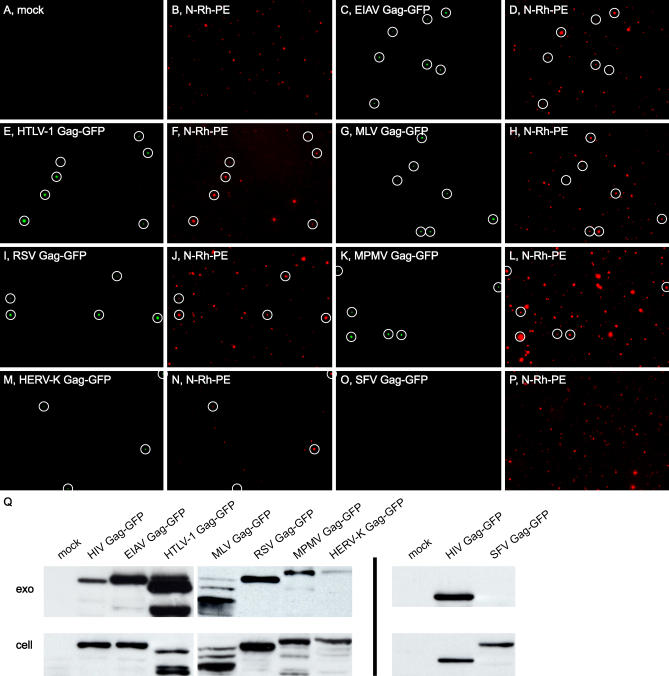
Jurkat T Cells Selectively Sort Orthoretroviral Gag Proteins to Exosomes(A–P) Fluorescence microscopy of exosomes secreted by N-Rh-PE–labeled Jurkat T cells (A and B) untransfected (mock) or transfected with plasmids that express GFP-tagged Gag proteins from (C and D) EIAV, (E and F) HTLV-1, (G and H) MLV, (I and J) RSV, (K and L) MPMV, (M and N) HERV-K, or (O and P) SFV. White circles denote vesicles containing the Gag-GFP protein, almost all of which co-localize with the exosomal marker N-Rh-PE.(Q) Anti-GFP immunoblots of (upper panel) exosomes (exo) and (lower panel) cell lysates (cell) (using the same exosome:cell ratio for all samples) from mock-transfected (mock) Jurkat T cells and Jurkat T cells expressing GFP-tagged Gag proteins from HIV, EIAV, HTLV-1, MLV, RSV, MPMV, HERV-K, and SFV. Bar indicates 10 μm.